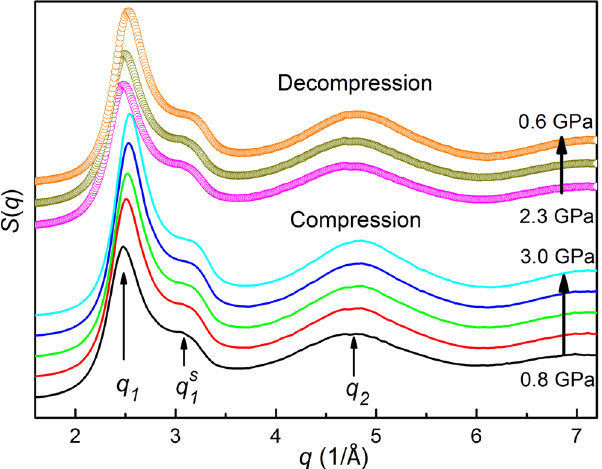
Figure 2. Structure factors S ( q ) of Ga 85.8 In 14.2 alloy obtained by XRD before crystallization during compression (lower part, solid lines by a shift in y axis) and after vitrification during decompression (upper part, circles by a shift in y axis). The arrows show the principle peaks ( q 1 and q 2 ) as well as the small sub-peak ( q 1s ) separated from the first main